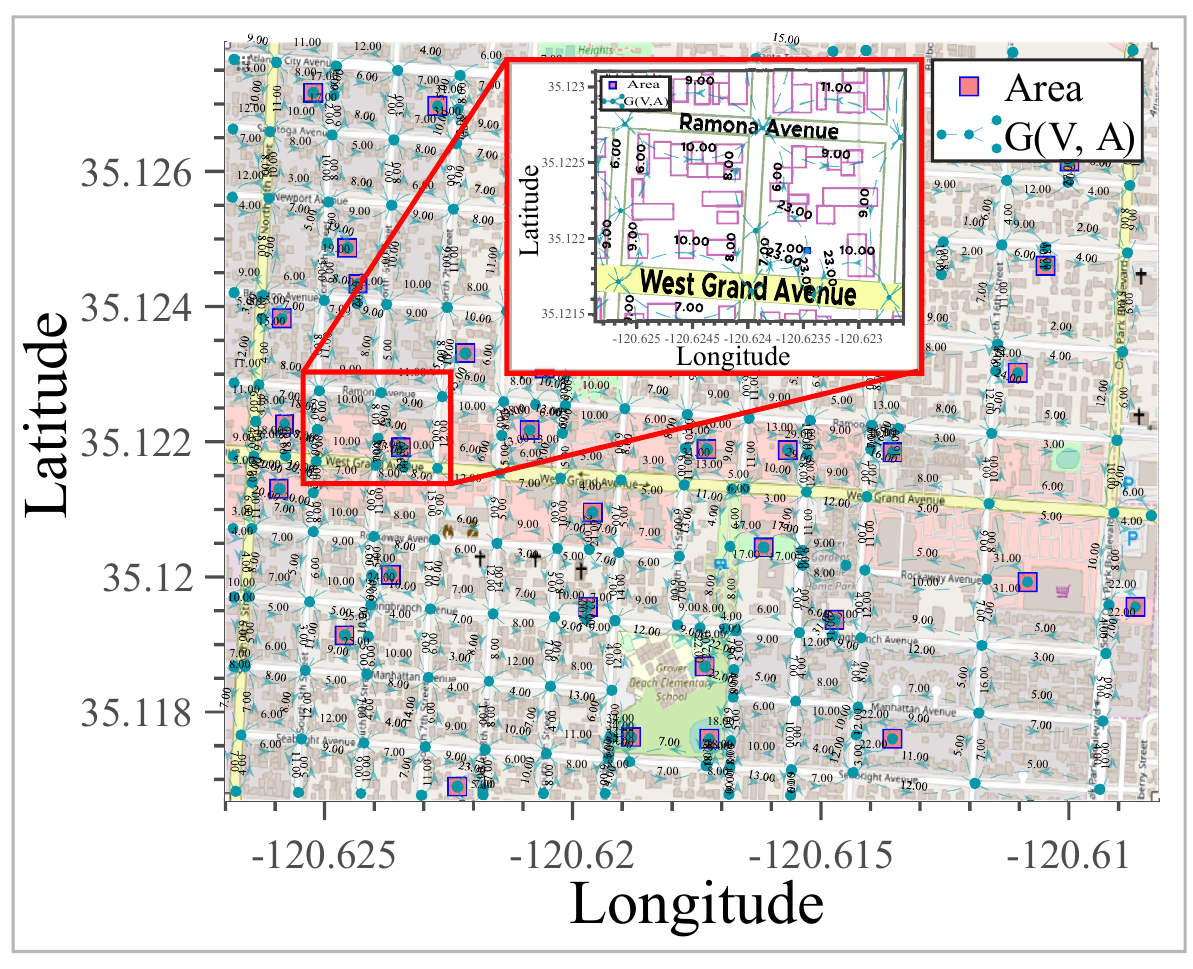
Figure 4. Case A, Grover Beach with an area of 2.13 km 2 , a city in San Luis Obispo County, US